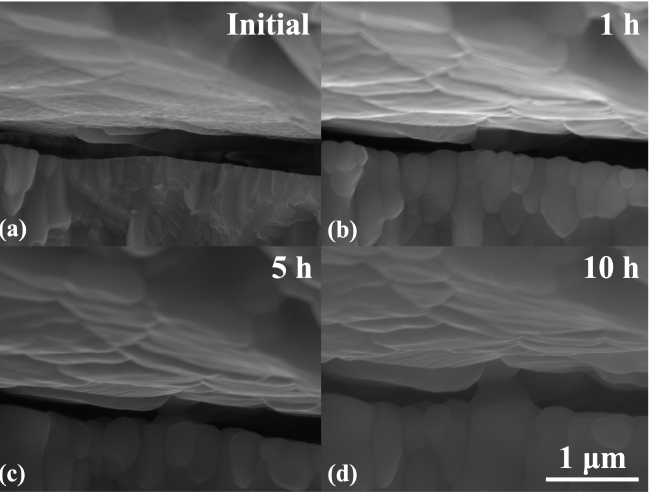
Figure 7. Quasi-in situ healing of intersplat pores during thermal exposure (SEM HV:15.0 kV, WD:5.00 mm, MAG: 80.0 kx). ( a ) initial state; ( b ) 1 h; ( c ) 5 h; ( d ) 10 h.